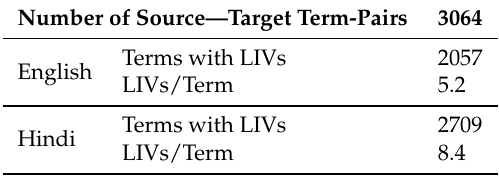
Table 3. Statistics of the occurrences of terms in the gold-test